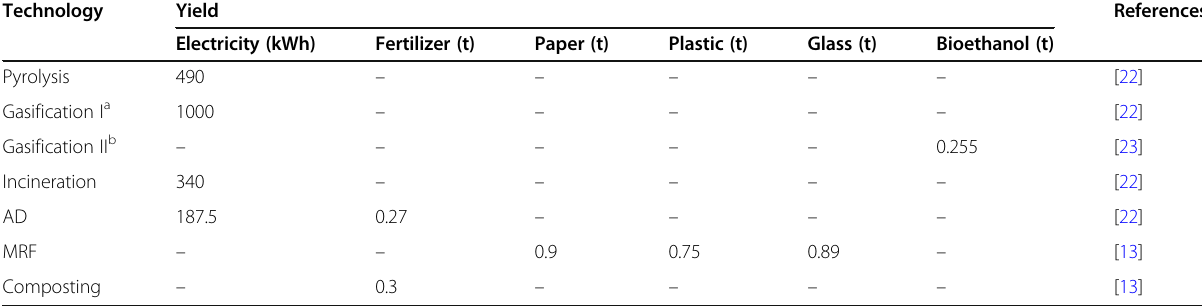
Table 1 List of the waste processing technology used in the superstructure and the product yields per ton of MSW